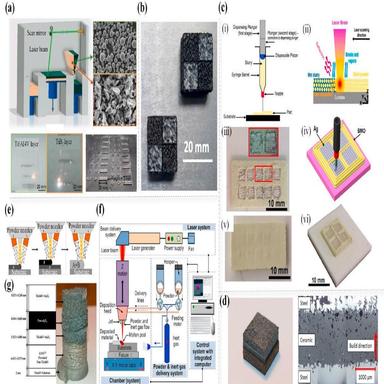
Multi-material ceramic additive manufacturing technologies based on powder melting mechanism: (a) multi-material LPBF technology and printed layered ceramic/metal structure, (b) SLM-based in-situ metal/ceramic multi-material part forming method , (c) low-temperature sintered Bi2Mo2O9 ceramics with silver floating electrodes prepared on the basis of SLM, (d) steel-ceramic-steel multilayer structure prepared on the basis of SLM, (e) schematic diagram of LENS formed m